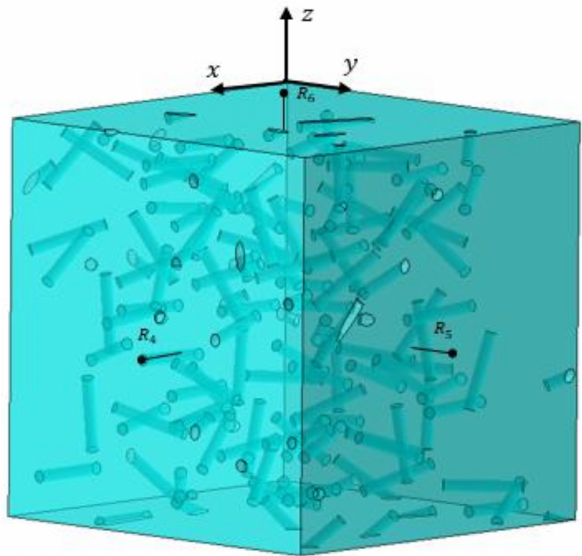
Figure 6. Schematic diagram of PBC for an